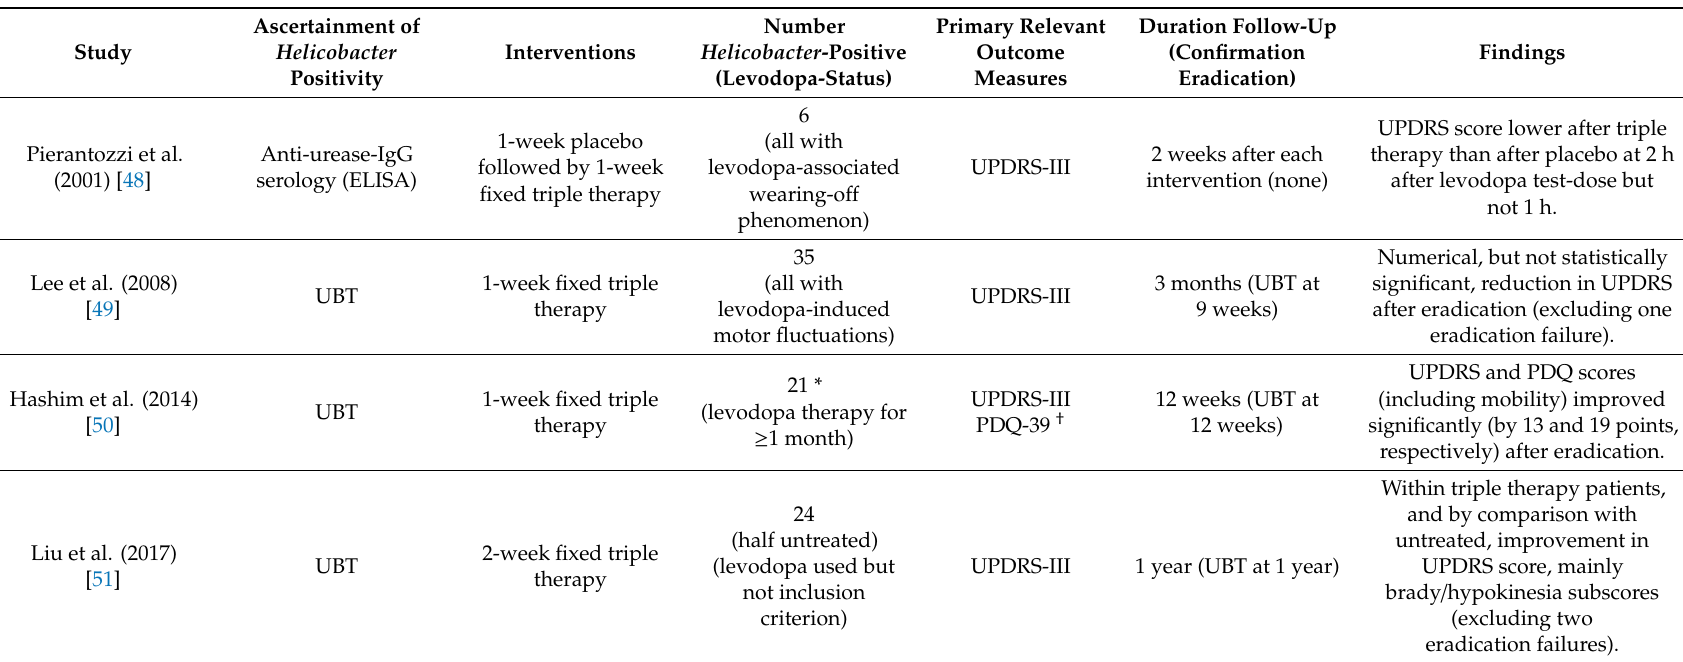
Table 2. Non-randomised trials of e ff ect Helicobacter eradication on severity of, and hypokinesia in, idiopathic